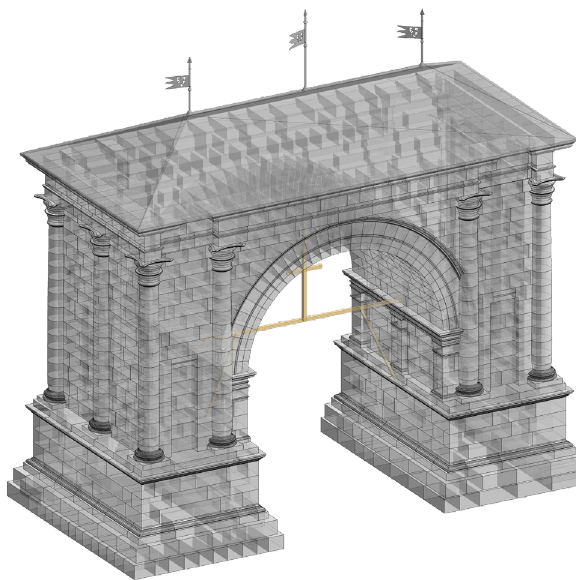
Figure 2 Maximus granularity for the BIM model of the north façade of the